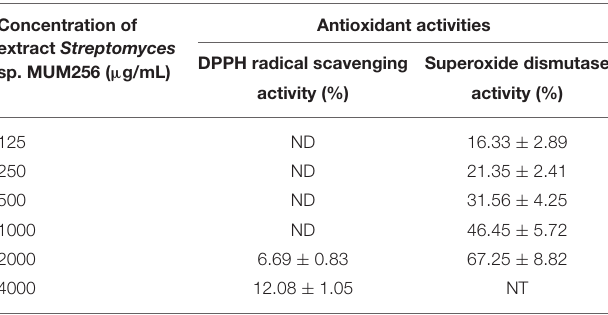
TABLE 1 | The antioxidant activities demonstrated by MUM256 extract in both DPPH assay and SOD activity assay. Concentration of extract Streptomyces